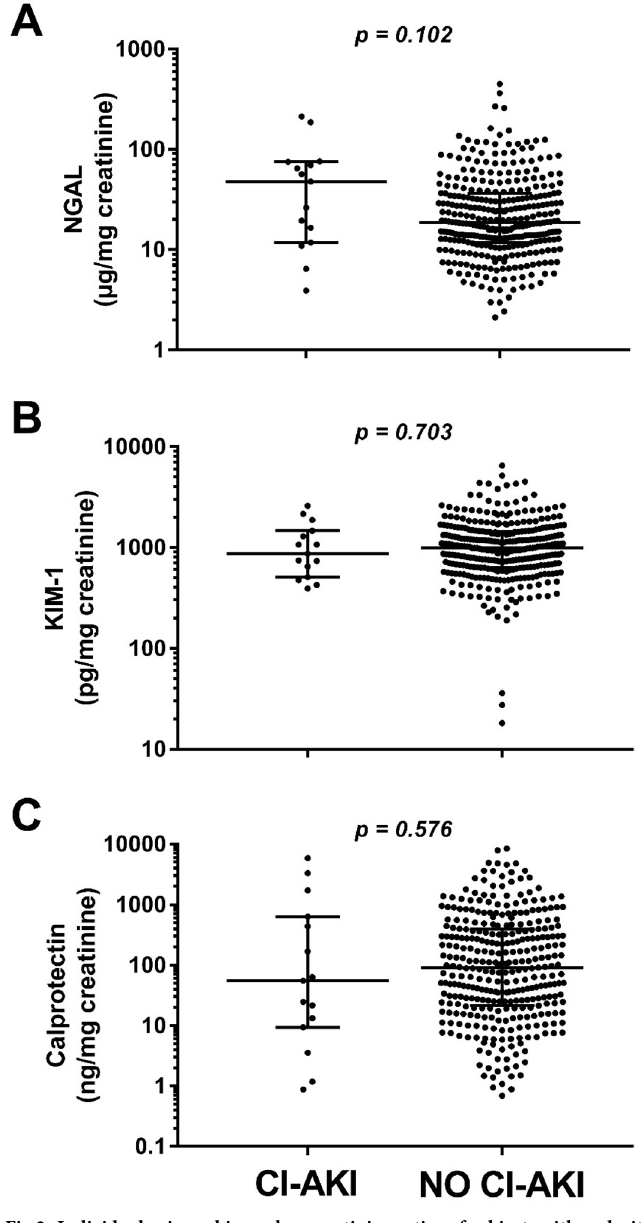
Fig 2. Individual urinary biomarker-creatinine ratios of subjects with and without contrast media induced acute kidney injury (CI-AKI) after coronary angiography in the subgroup of patients without clinically overt kidney disease (eGFR > 60 ml, ACR > 30 mg/g creatinine; left column). Analyses are presented for (A) neutrophil gelatinase-associated lipocalin (NGAL), (B) kidney injury molecule-1 (KIM-1), and (C) calprotectin. Data are presented as scatter plots (logarithmic Y-axis, medians and interquartile ranges are indicated by horizontal lines). Significant differences were ��� p < 0.001, �� p < 0.01 and � p < 0.05 by Mann-Whitney testing.